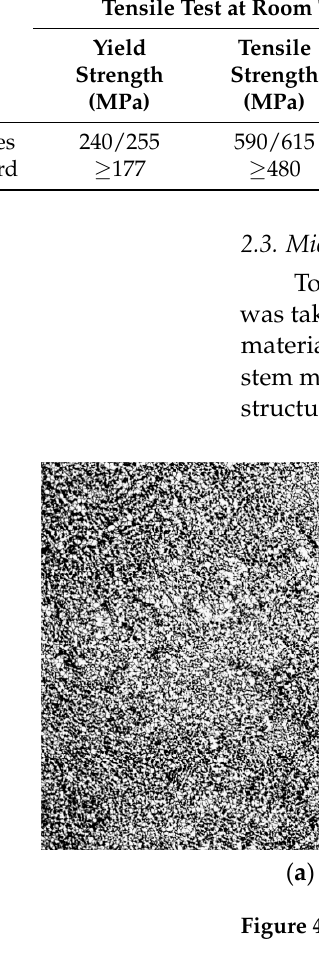
Table 3. Mechanical properties test results.